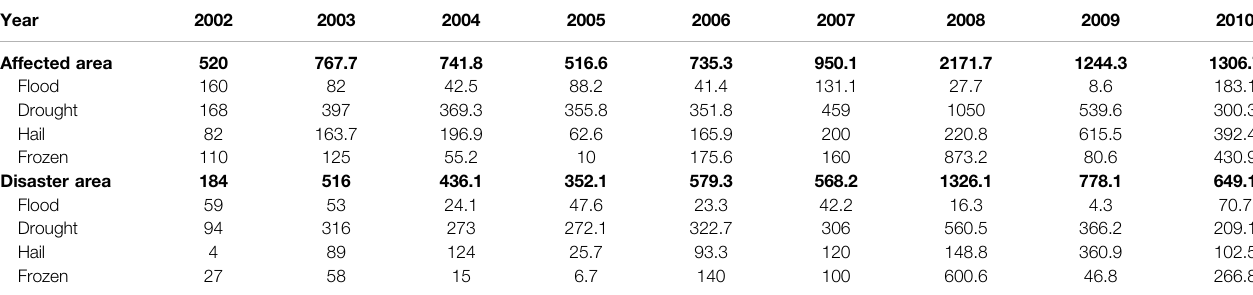
TABLE 1 | Statistical table of agricultural disaster-affected and disaster-affected areas in Xinjiang from 2001 to 2010 (unit: 1000 ha).